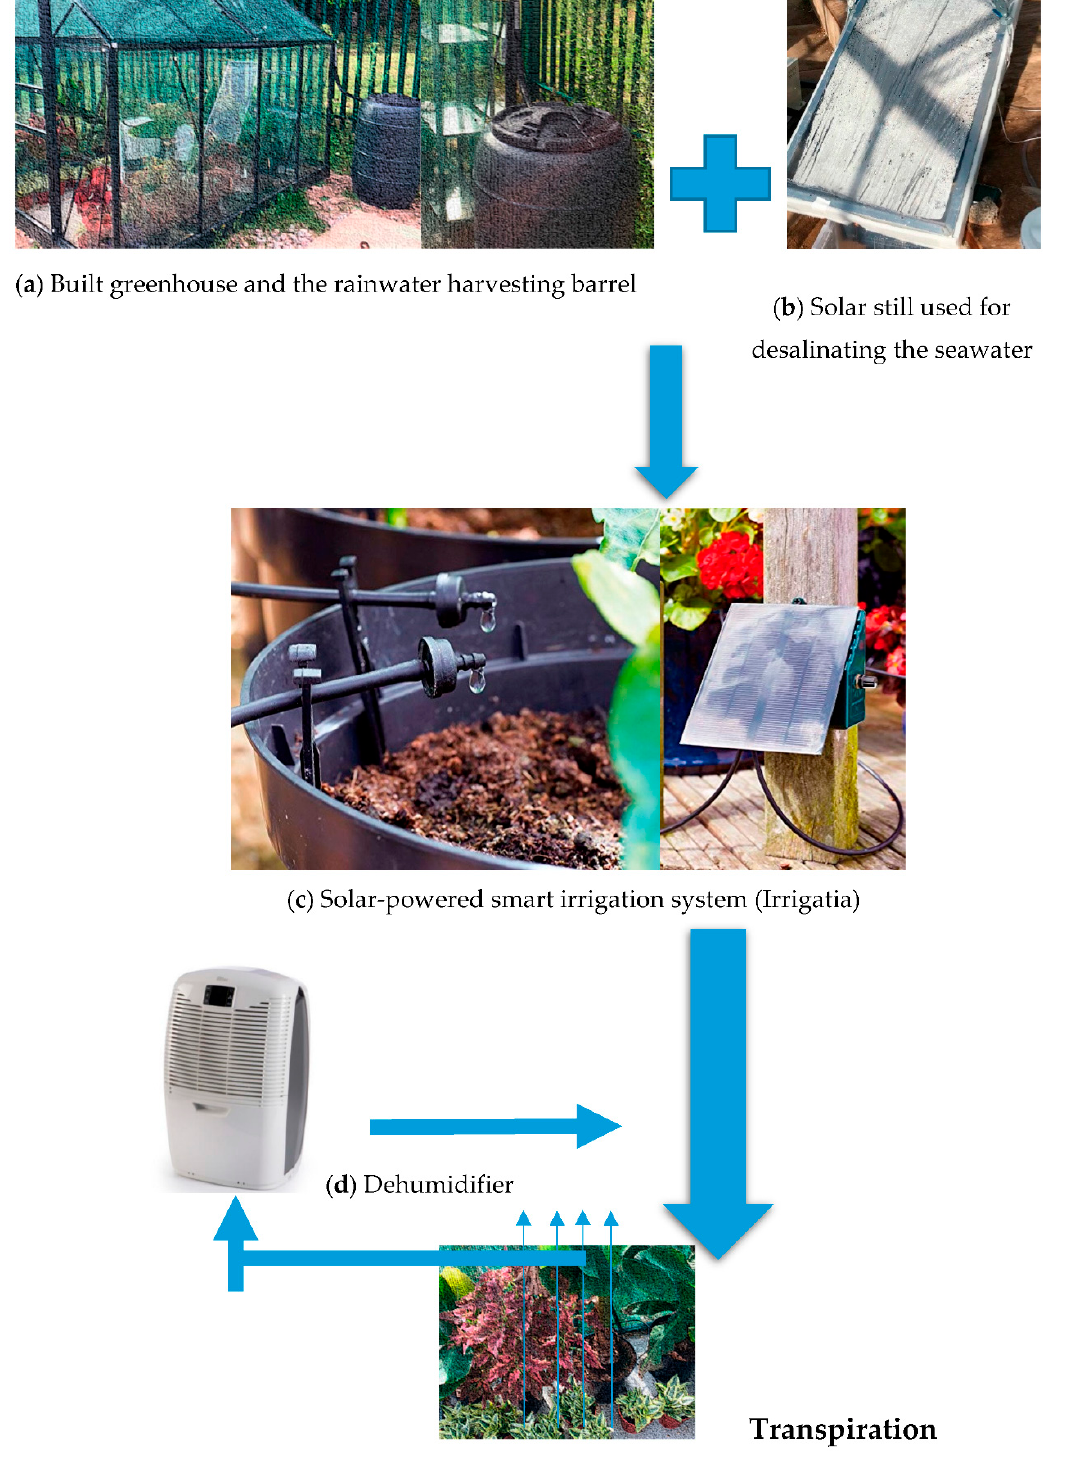
Figure 5. Di ff erent parts of the sustainable ZLD greenhouse model. ( a ) Built greenhouse and the rainwater harvesting barrel. ( b ) Solar still used for desalinating the seawater. ( c ) Solar-powered smart irrigation system (Irrigatia). ( d ) Dehumidifier.